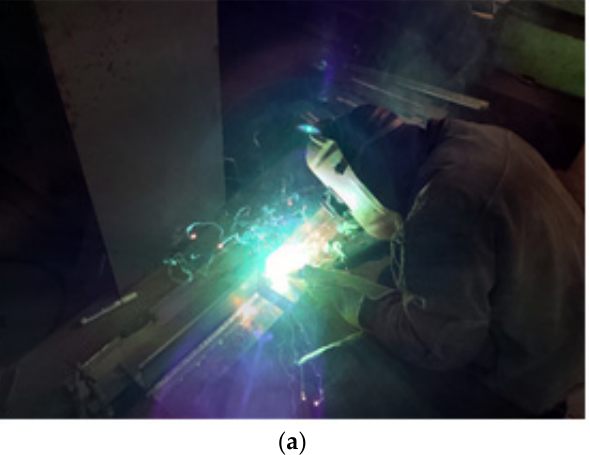
Figure 3. ( a ) Fillet welding; ( b ) Butt welding.